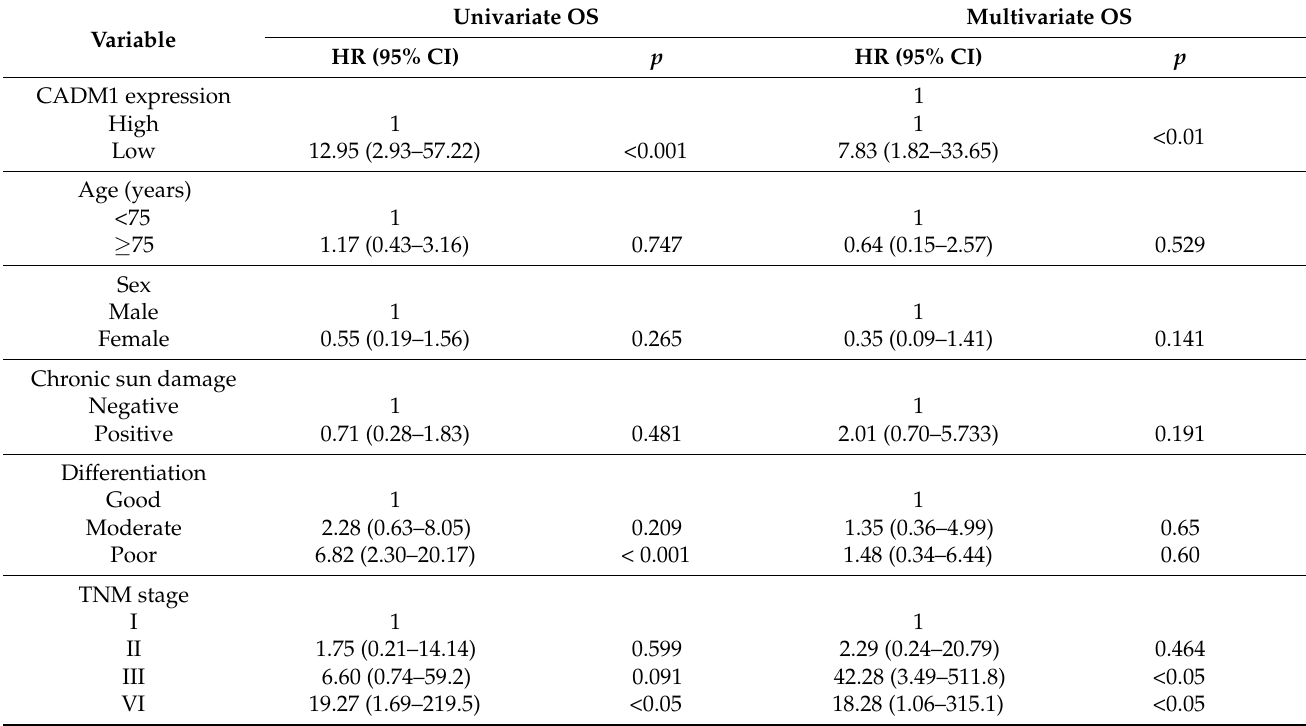
Table 3. Univariate and multivariate